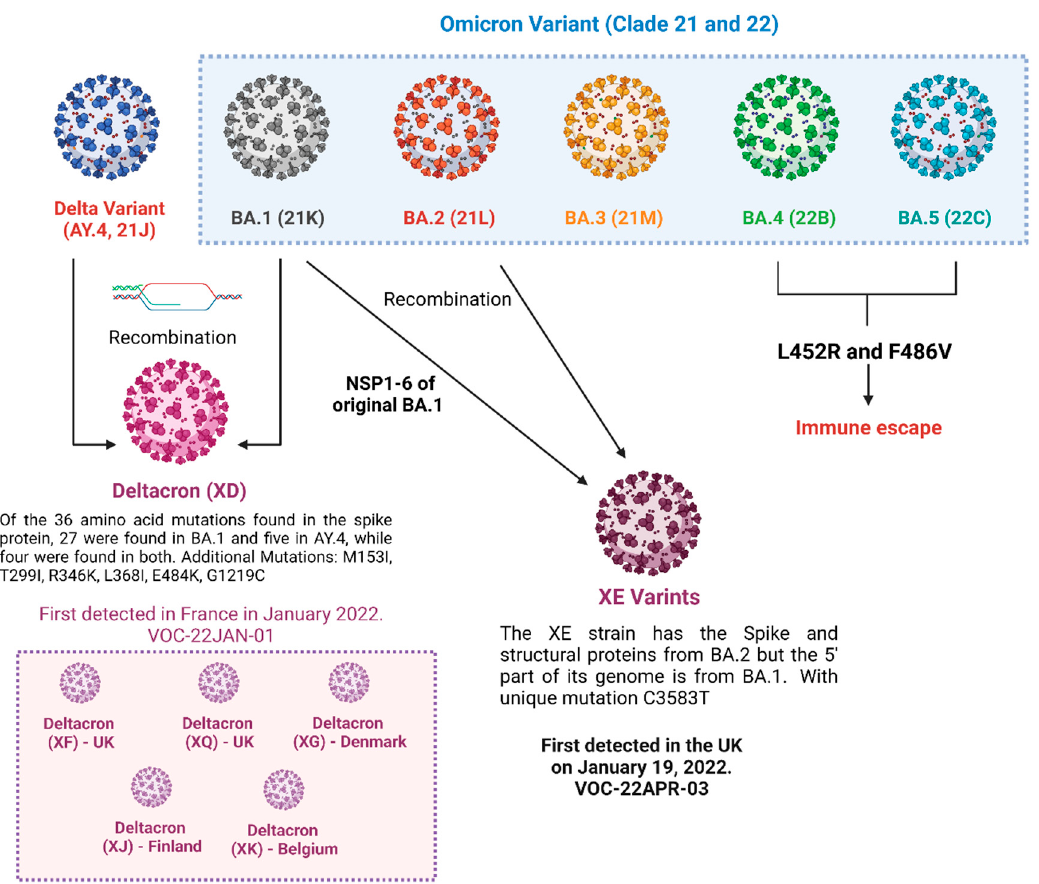
Figure 1 . Hybrid variants of SARS-CoV-2. Figure 1. Hybrid variants of